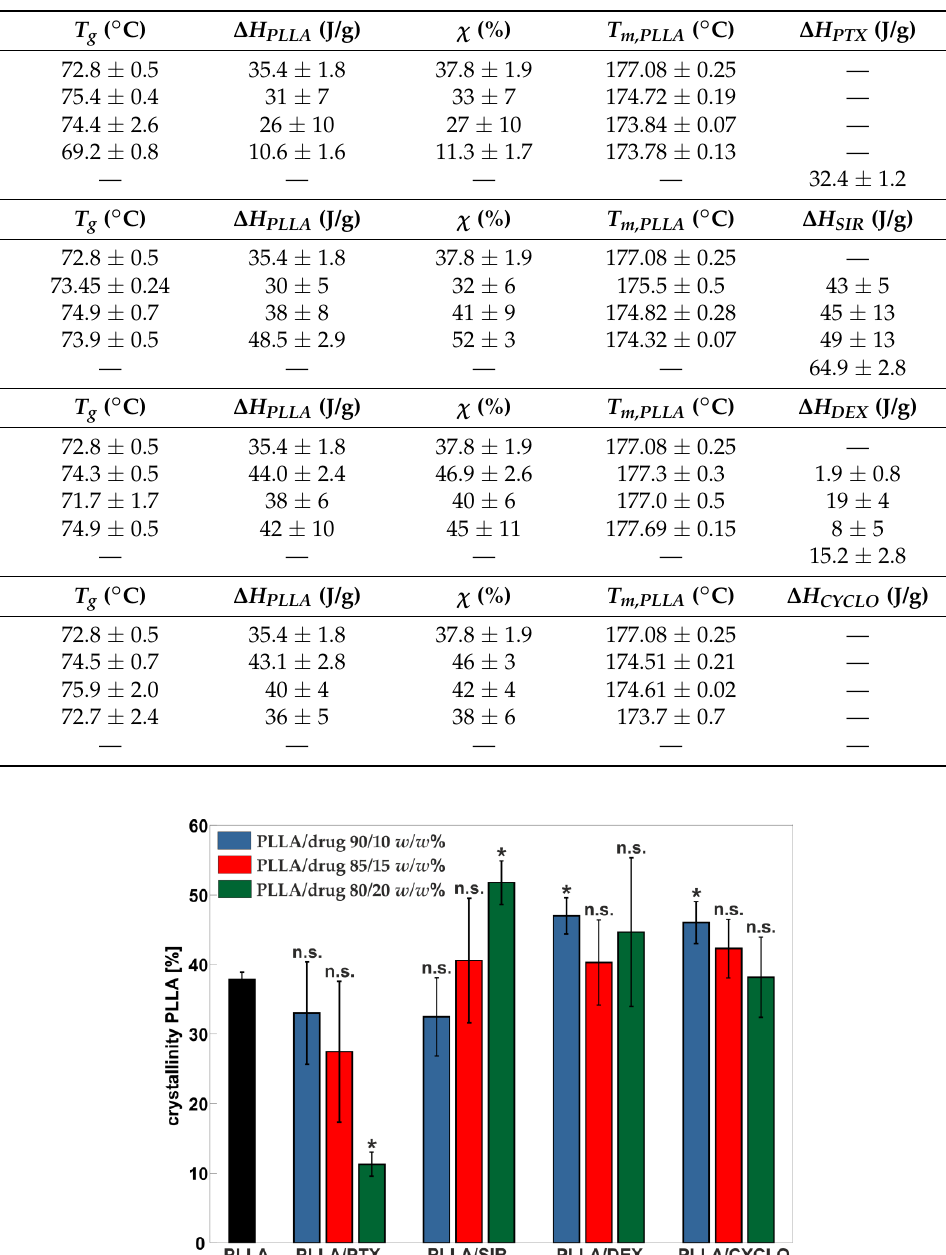
Table 3. DSC results (glass transition ( T g ), melting temperature ( T m ) and degree of crystallinity ( χ )) of PLLA/drug spray coated films in different ratios (90/10, 85/15, 80/20 w / w %) (n = 5 for each group). * in T m,DEX* indicates that shift in melting point occurs in comparison to pure drug.